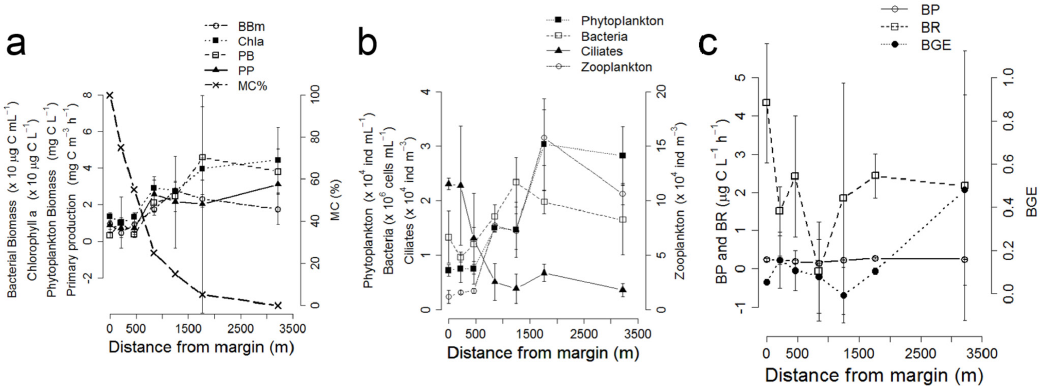
Figure 4. Upper panel (a): bacterial biomass (BBm), chlorophyll a (Chla), phytoplankton biomass (PB), primary production (PP) and macrophyte coverage (MC%); middle panel (b): phytoplankton, bacterial, ciliates and zooplankton density; lower panel (c): bacterial production (BP), bacterial respiration (BR) and bacterial growth efficiency (BGE) along a transect running from a macrophyte dominated littoral to a phytoplankton dominated pelagic zone in Lake Mangueira. Bars represent standard deviations (n =